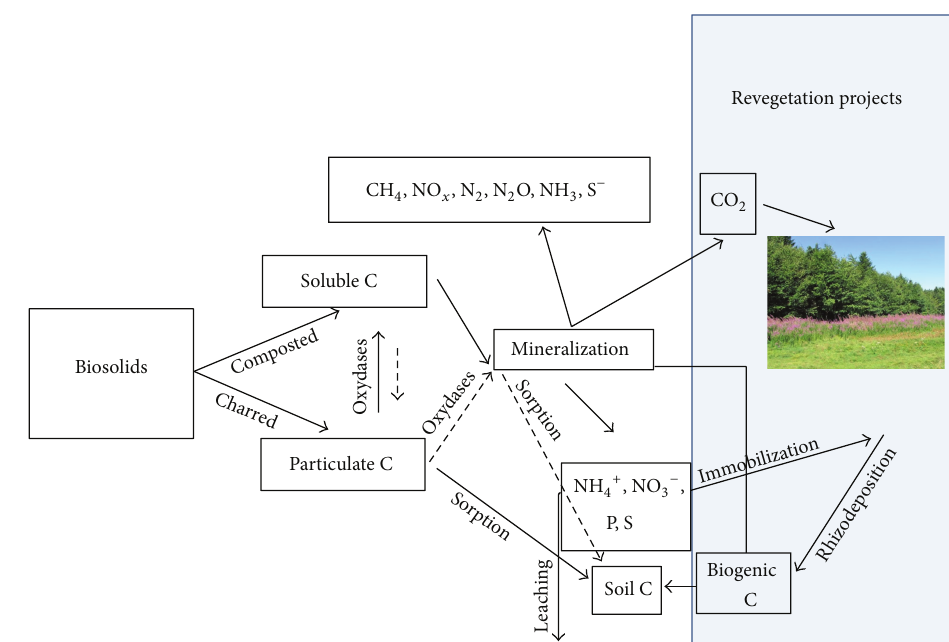
Figure 4: Schematic contribution of biosolids-borne C to SOC fractions and to soil nutrient fluxes, in addition to biogenic extra C inputs in mine spoils revegetation projects. The dotted lines indicate the still poorly understood effect of oxydases on particulate C mineralization or the stabilization of mineralized soil C by